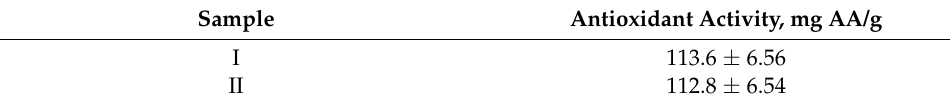
Table 5. The results of determining the antioxidant activity of the Symphytum officinale extract